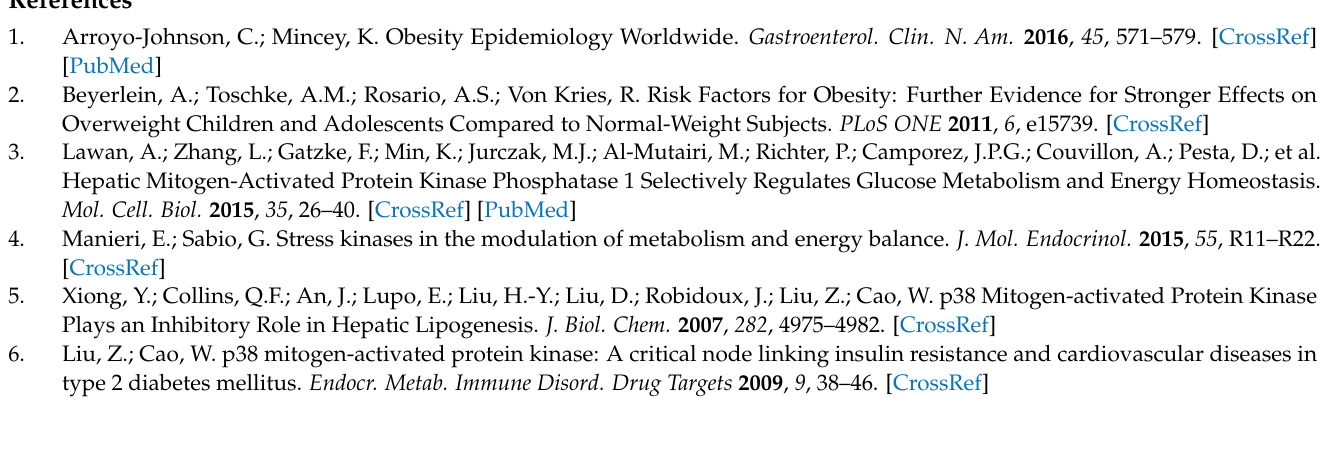
Fatty Liver Disease; Figure S2: No difference in histology of MKP-2 deficient mice and wild type mice; Figure S3: Skeletal muscle and WAT histology of MKP-2 deficient mice and wild type mice; Figure S4: MAPK Phosphorylation in chow-fed MKP-2 Deficient Mice; Figure S5: Glucose Tolerance and Insulin Sensitivity in female Chow and HFD-fed MKP-2 Deficient Mice; Figure S6: No difference in WAT Akt phosphorylation in MKP-2 deficient mice and